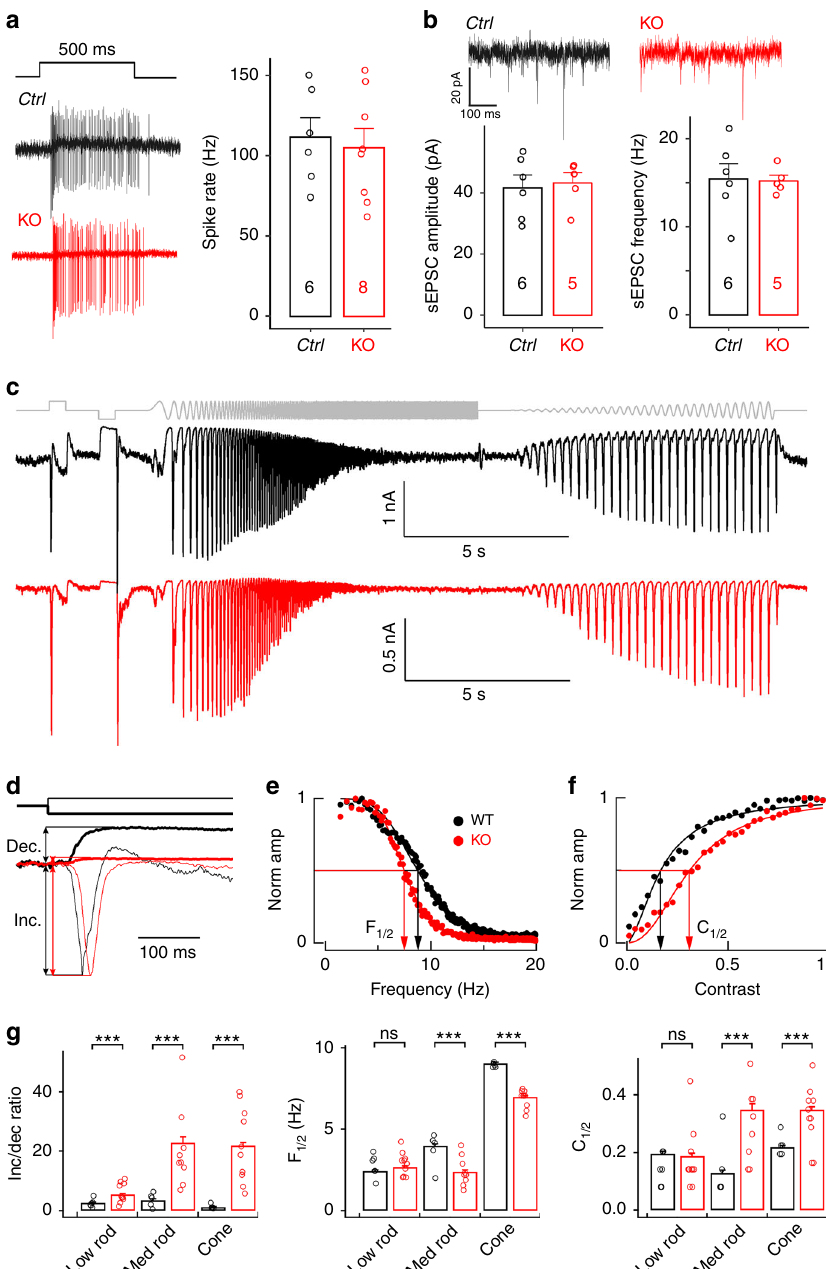
Fig. 7 Light response properties and synaptic transmission in ribeye-ko mice. a (Left) Action potentials of ON-alpha RGCs evoked by a 500 ms light fl ash. (Right) Average fi ring rates during the stimulation duration. b (top) Whole-cell voltage-clamp recording of spontaneous excitatory postsynaptic currents (sEPSCs) from ctrl and KO. (bottom) Mean amplitude and frequency of sEPSCs. c Chirp stimulus (top) and example excitatory synaptic inputs to ON-alpha RGCs from ribeye knockout (red) and littermate control (black) retinas. d Increment and decrement responses from fi rst section of chirp stimulus. The increment/decrement ratio determines how large the tonic excitatory input (i.e., the current suppressed by the decrement) is compared to the maximal excitatory input (i.e., the current in response to the increment). e Responses to frequency ramp. The amplitude of the response to each cycle of the stimulus is plotted against temporal frequency. Frequency tuning was measured from the frequency (F 1/2 ) at which the response fell to half of its maximal value. f Responses to contrast ramp. The amplitude of the response to each cycle of the stimulus is plotted against contrast. Contrast sensitivity was measured from the contrast (C 1/2 ) at which responses reached half maximum. g Summary of increment/decrement ratios (left), frequency tuning (middle) and contrast sensitivity (right) across cells. Low rod light level is 2 R*/rod/s, medium rod is 50 R*/rod/s and cone is 2000 R*/cone/s. *** denotes p < 0.001 (unpaired t -test). Data are presented as mean ±